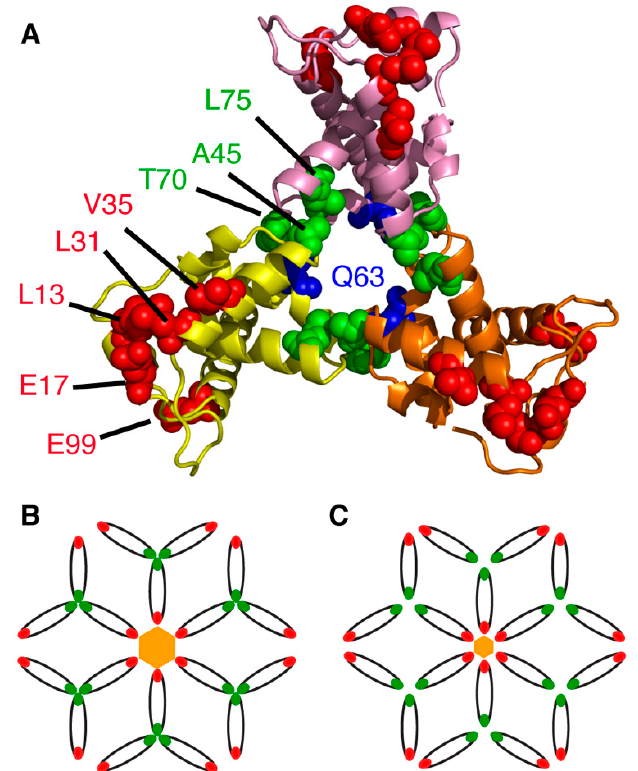
Figure 3. MA structural motifs that mediate Env incorporation. ( A ) Structure of the MA trimer (PDB ID: 1HIW) highlighting residues implicated in Env incorporation (red and green). The current hypothesis is that the revertant mutant Q63R enhances MA trimerization, thereby increasing MA affinity to gp41CT and enhancing Env incorporation. ( B ) Schematic representation of the hexamer of trimer arrangement of MA based on the models proposed Alfadhli et al. [107] and adopted by Freed et al. [108] to explain the mechanisms of Env incorporation. In this model, a ∼ 45 nm central aperture is formed by residues implicated in Env incorporation (red). It is hypothesized that the gp41CT protein is accommodated in the central aperture. Other mutations that were found to significantly disrupt Env incorporation are located in the trimer interface (green). ( C ) Based on an early model [110], perturbations of the putative hexameric or trimeric interface in the MA lattice are thought to create smaller central apertures ( ∼ 30 nm) that may cause a steric exclusion of gp41CT.